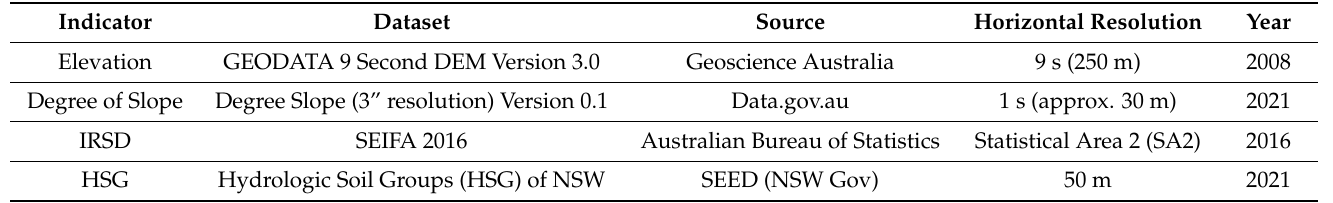
Table 2. Dataset summary for map layers used in this study, including their source. Indicator Dataset Source Horizontal Resolution